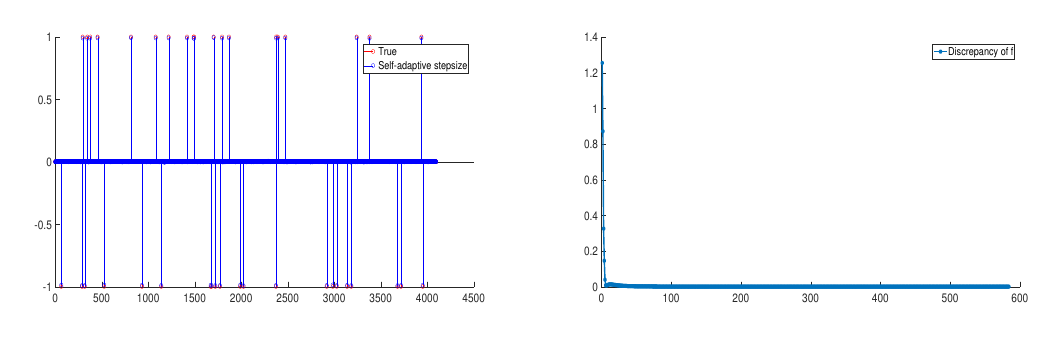
Figure 5. Numerical result for K =